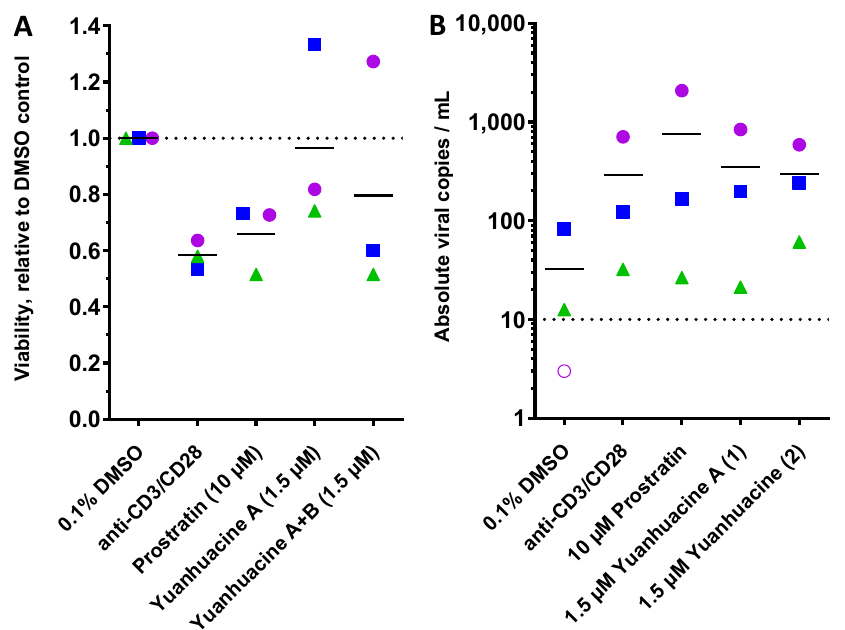
Figure 6. Effects of 10 µ M prostratin and 1.5 µ M of yuanhuacine A ( 1 ) or yuanhuacine (as an isomeric mixture) ( 2 ) on cell viability ( A ) and absolute viral RNA copies/mL of supernatant ( B ) in primary CD4+ cultures from 3 cART-suppressed donors with HIV following 24 h treatment. For both panels, shapes, and colors denote individual donors. In panel ( B ), the dotted line denotes limit of detection, and empty shape denotes no viral RNA detected.